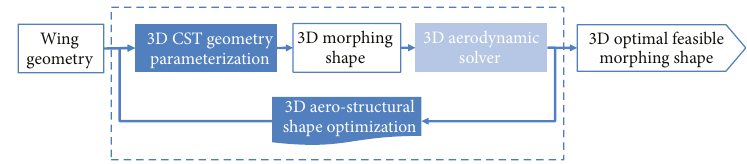
Figure 18: Aerostructural shape design: integrated approach.